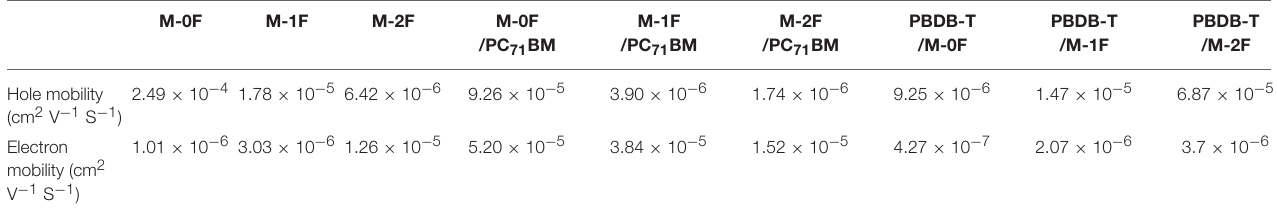
TABLE 3 | SCLC measured hole mobility and electron mobility for pure M-0F, M-1F, M-2F, and their PC 71 BM or PBDB-T blends.